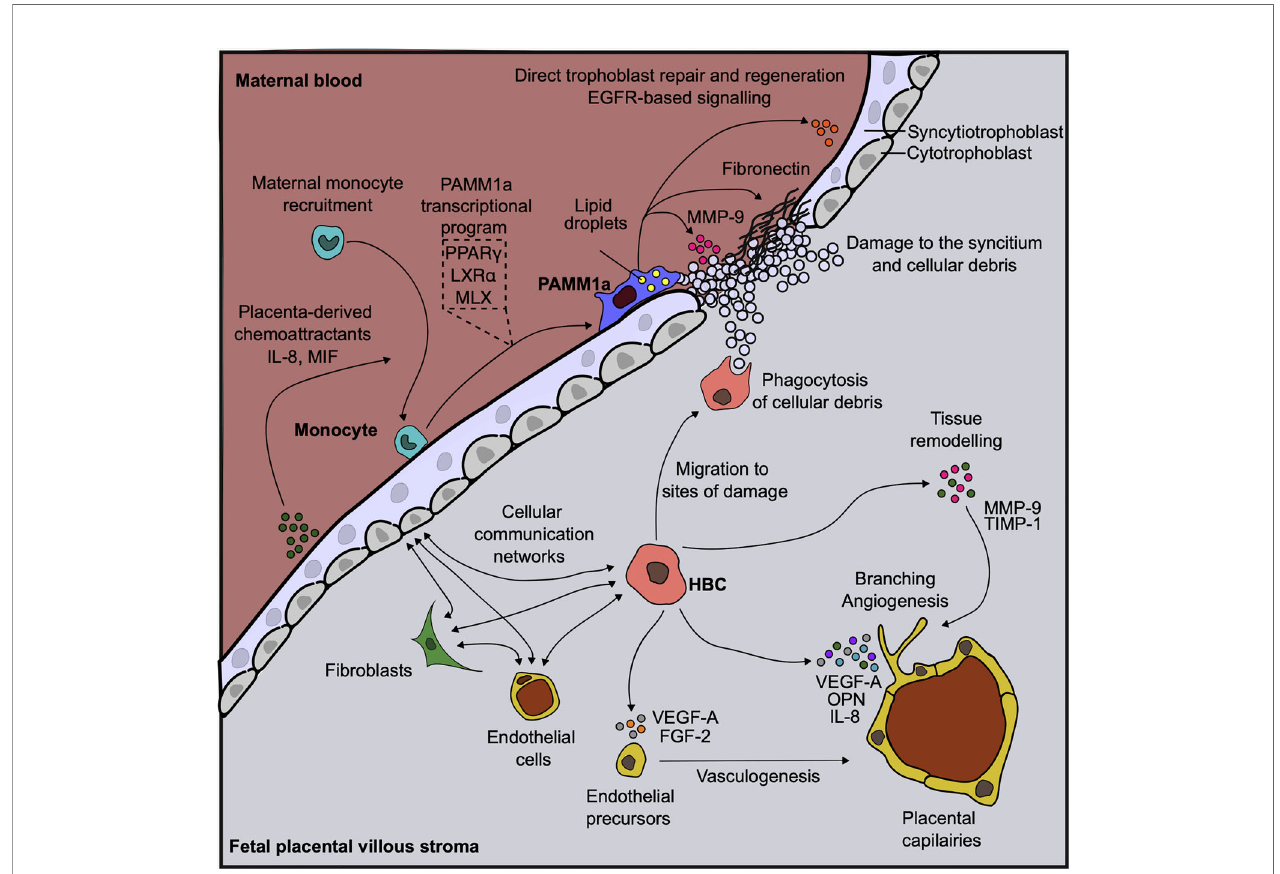
FIGURE 2 | Human placental macrophages have diverse functional properties. Diagram demonstrating the diverse roles that placenta associated maternal macrophages (PAMM1a) and Hofbauer cells (HBC) are thought to play in the steady-state. Vasculature endothelial growth factor, (VEGF); fi broblast growth factor, (FGF); osteopontin, (OPN); matrix metalloprotease, (MMP); tissue inhibitor of metalloproteinase, (TIMP); Max-like protein X, (MLX); liver X receptor, (LXR); peroxisome proliferator-activated receptor, (PPAR); endothelial growth factor receptor, (EGFR); macrophage migration inhibitory factor, (MIF); interleukin,